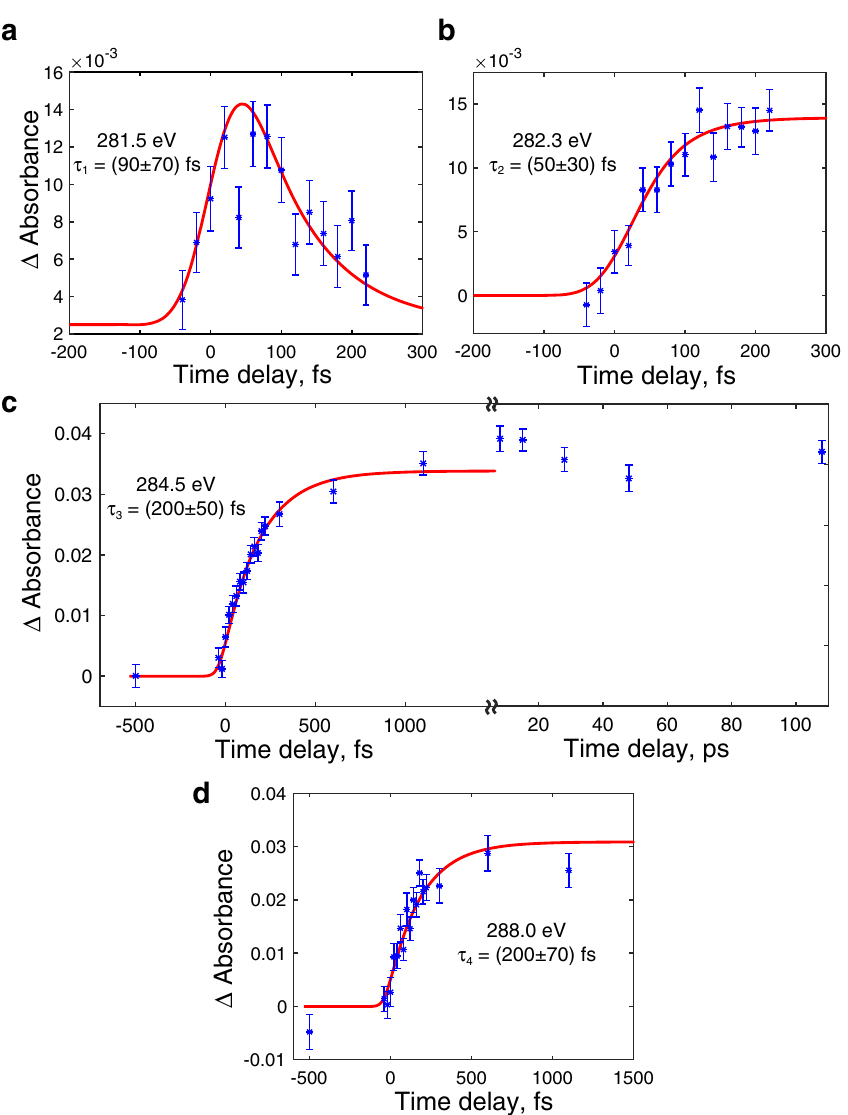
Fig. 4 Time dependence of absorbance at selected energies. a 281.5eV, red line is the convolution of the instrument response function (IRF) with exponent e (cid:1) t = τ 1 , where τ 1 = (90 ± 70) fs. b 282.3 eV, red line is the convolution of IRF with the function (1 (cid:1) e (cid:1) t = τ 2 ), where τ 2 = (50 ± 30) fs. c 284.5 eV, red line is the convolution of IRF with 1 (cid:1) e (cid:1) t = τ 3 , where τ 3 = (200 ± 50) fs. d 288.0 eV, red line is the convolution of the IRF with 1 (cid:1) e (cid:1) t = τ 4 , where τ 4 = (200 ± 70) fs. Error bars in all panels represent one standard deviation of 128